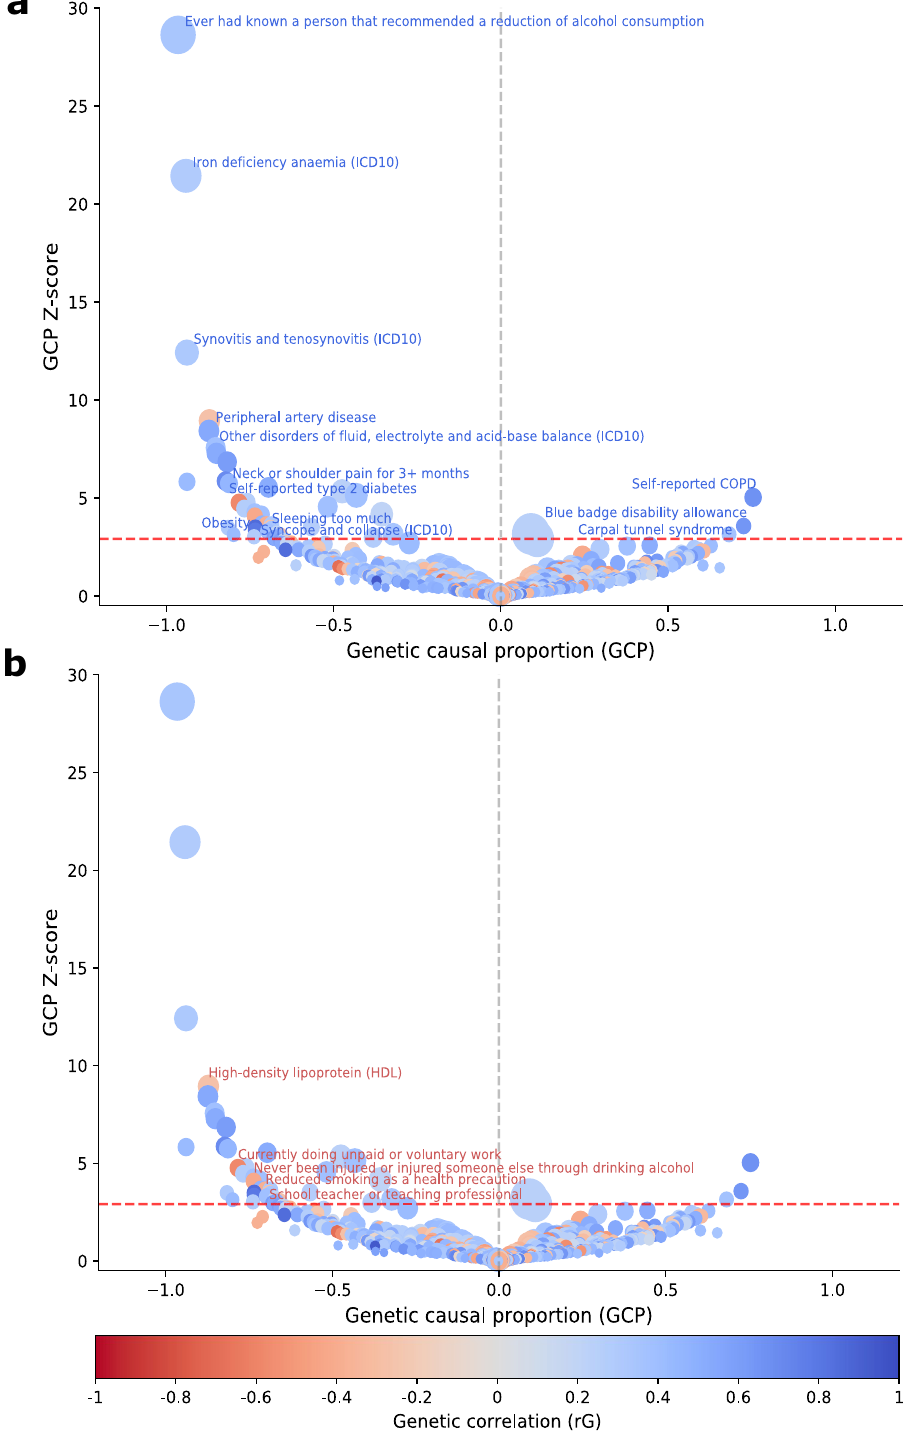
Figure 1. Causal architecture of ADHD. Causal architecture plots illustrating results from the phenome-wide analysis. Each dot represents a trait with genetic overlap with ADHD. The x-axis shows the GCP estimate, and the y-axis shows the genetic causal proportion (GCP) absolute Z-score (as a measure of statistical significance). The red dashed lines represent the statistical significance threshold (FDR < 5%). The division for traits causally influencing ADHD (on the left) and traits causally influenced by ADHD (on the right) is represented by the grey dashed lines. Results are shown separately for traits with a positive genetic correlation with ADHD ( a ) and a negative genetic correlation with ADHD ( b ). A GCP = 0 indicates that horizontal pleiotropic effects mediate the genetic correlation (i.e., provides no evidence for genetic causality between the phenotypes), whereas a |GCP| = 1 represents full genetic causality. A |GCP| < 0.60 represents limited partial genetic causality. A detailed description of how to interpret these plots is available in previous studies 46,47